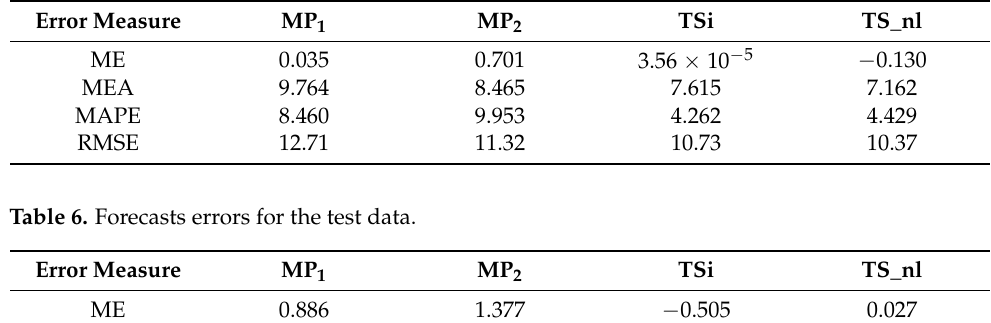
Table 5. Forecasts errors for the training data.